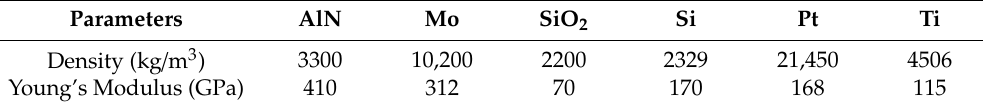
Table 2. The parameters of each material from COMSOL Multiphysics library.